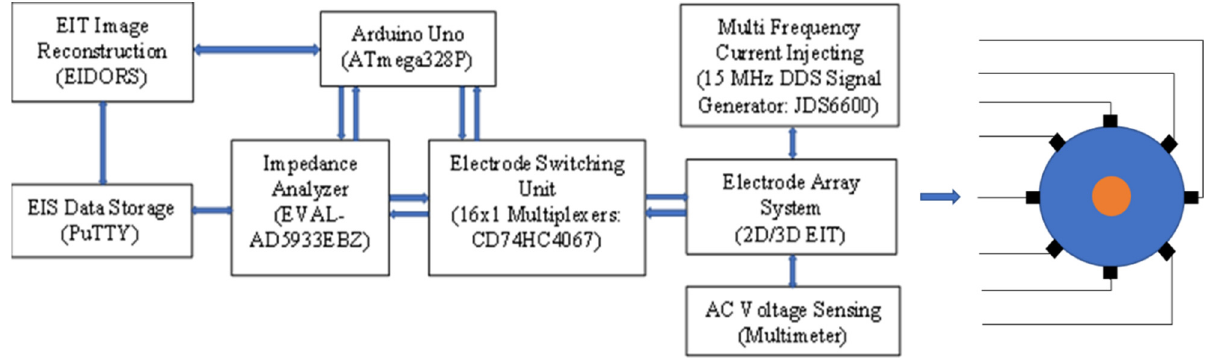
Figure 2. A developed EIT data acquisition system for 2D and 3D imaging.